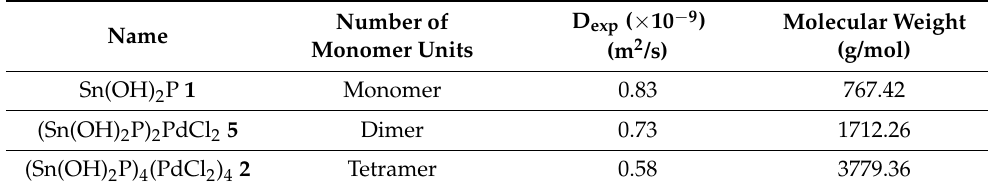
Table 1. Diffusion coefficients of compounds from the reaction mixture formed during the preparation of the porphyrin arrays with different numbers of structural units.